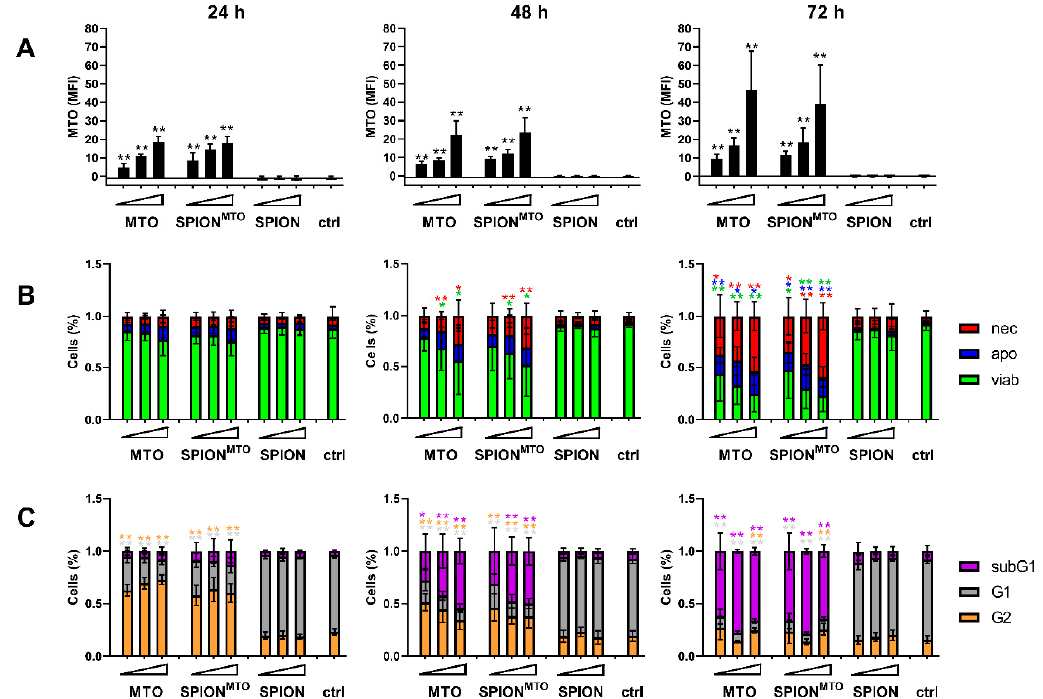
Figure 3. MTO uptake, cell cycle and cell death induction. HT-29 cells were treated with SPIONs, MTO, or SPION MTO for 24 h, 48 h, and 72 h. MTO concentrations of 0.5, 1.0 or 2.0 μ M (see triangle) and equivalent SPION concentrations were administered according to Table 2. H 2 O-treated cells served as controls. ( A,B ) Cells were stained with Annexin A5-FITC or -APC (Ax) and propidium iodide (PI) and analyzed via flow cytometry. ( A ) The mean fluorescence intensity (MFI) of viable cells (Ax − PI − ) was used to quantify intracellular MTO. ( B ) Ax − PI − cells are considered viable (viab), Ax + PI − are considered apoptotic (apo) and Ax + PI + are considered necrotic (nec). ( C ) Cell cycle was analyzed by PI-Triton staining in flow cytometry. G1 reflect cells with diploid DNA content, G2 reflect cells with double diploid DNA content, and subG1 are cells with degraded DNA. Shown are mean values of three independent triplicates with standard deviations. Significances were calculated using Student´s t -test for treatment groups versus control and MTO versus SPION MTO (* p < 0.05; ** p < 0.01).